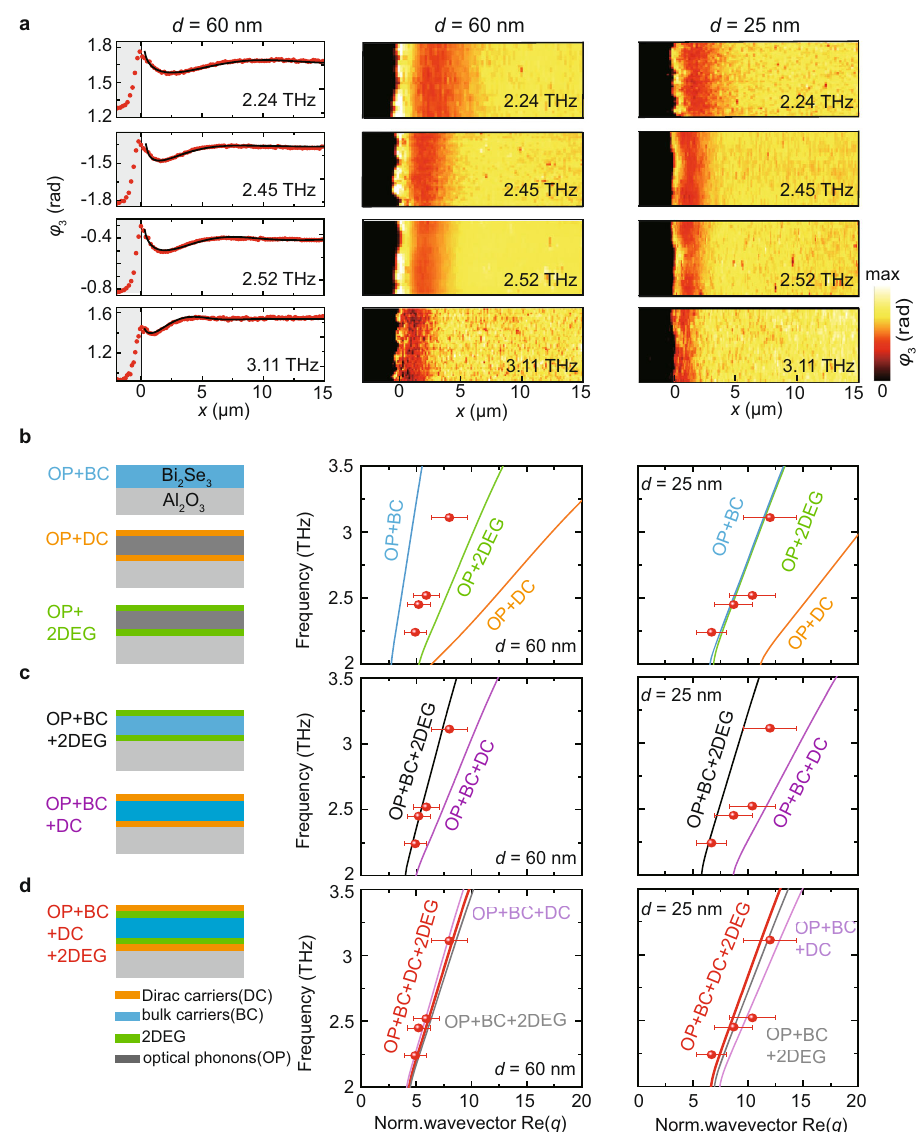
Fig. 4 Polariton dispersions in Bi 2 Se 3 fi lms with 60 nm and 25 nm thickness. a Right: near- fi eld phase images at different THz frequencies. Left: line pro fi les extracted from the images of the 60 nm thick fi lm. Experimental phase line pro fi le are shown in red color. Back lines show fi ts obtained by complex- valued fi tting as demonstrated in Fig. 2. b – d Red symbols in the diagrams show the polariton dispersions obtained by complex-valued fi tting of experimental line pro fi les as demonstrated in Fig. 2. Solid lines show calculated dispersions based on various conductivity models (described in main text), which are sketched on the left side. We consider various optical conductivity contributions based on optical bulk phonons (OP), massive bulk carriers (BC), Dirac carriers (DC) at both Bi 2 Se 3 surfaces, and massive two-dimensional electron gases (2DEG) at both Bi 2 Se 3 surfaces. Error bars indicate a 20% uncertainty of the wavevector, which we estimate conservatively from comparison of experimental and simulated near- fi eld line pro fi